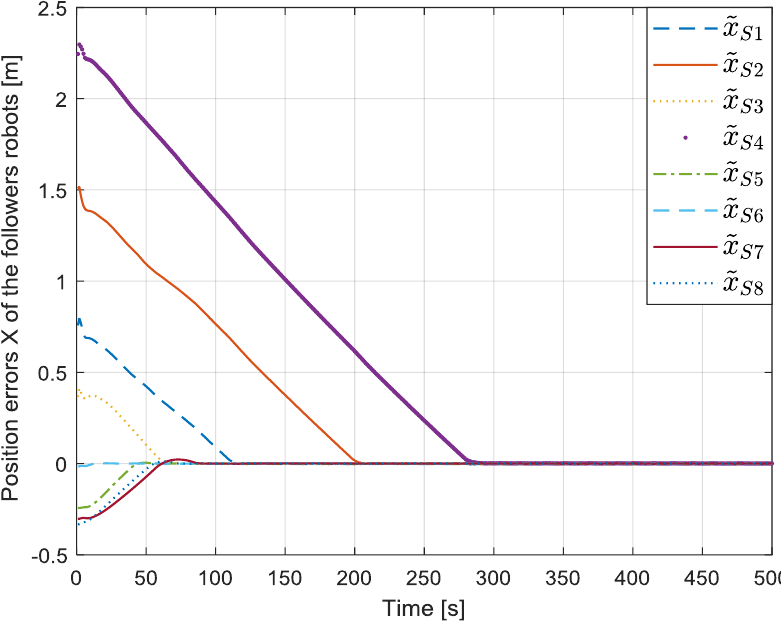
Figure 17. Position errors X of the follower robots